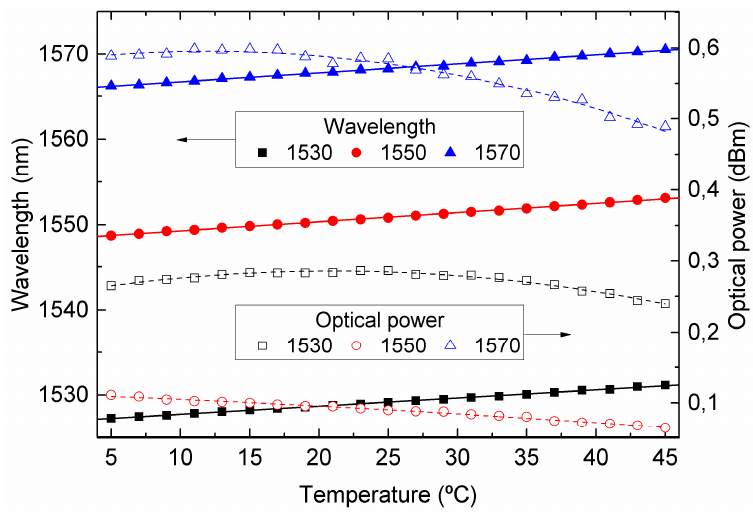
Figure 8. Wavelength and optical power shift for the temperature sweep of the three used DFB lasers centered at 1530, 1550, and 1570 nm, respectively.